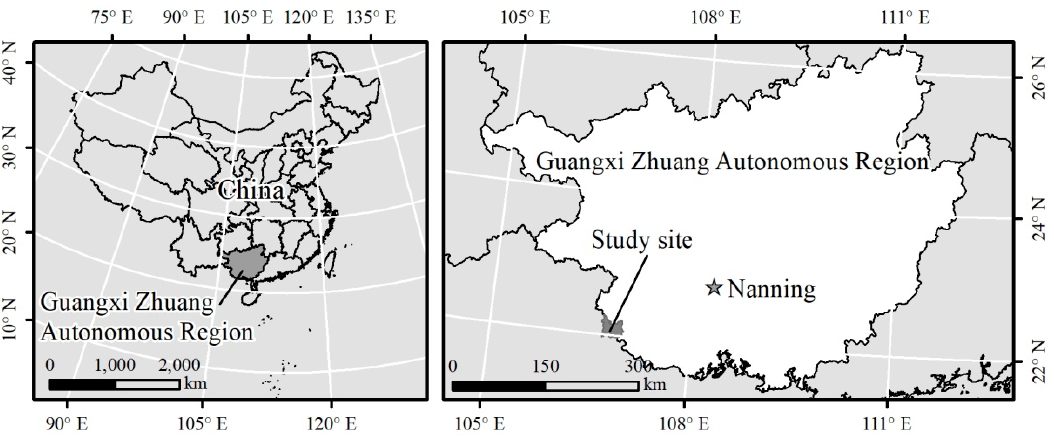
Figure 1. The location of the study site.